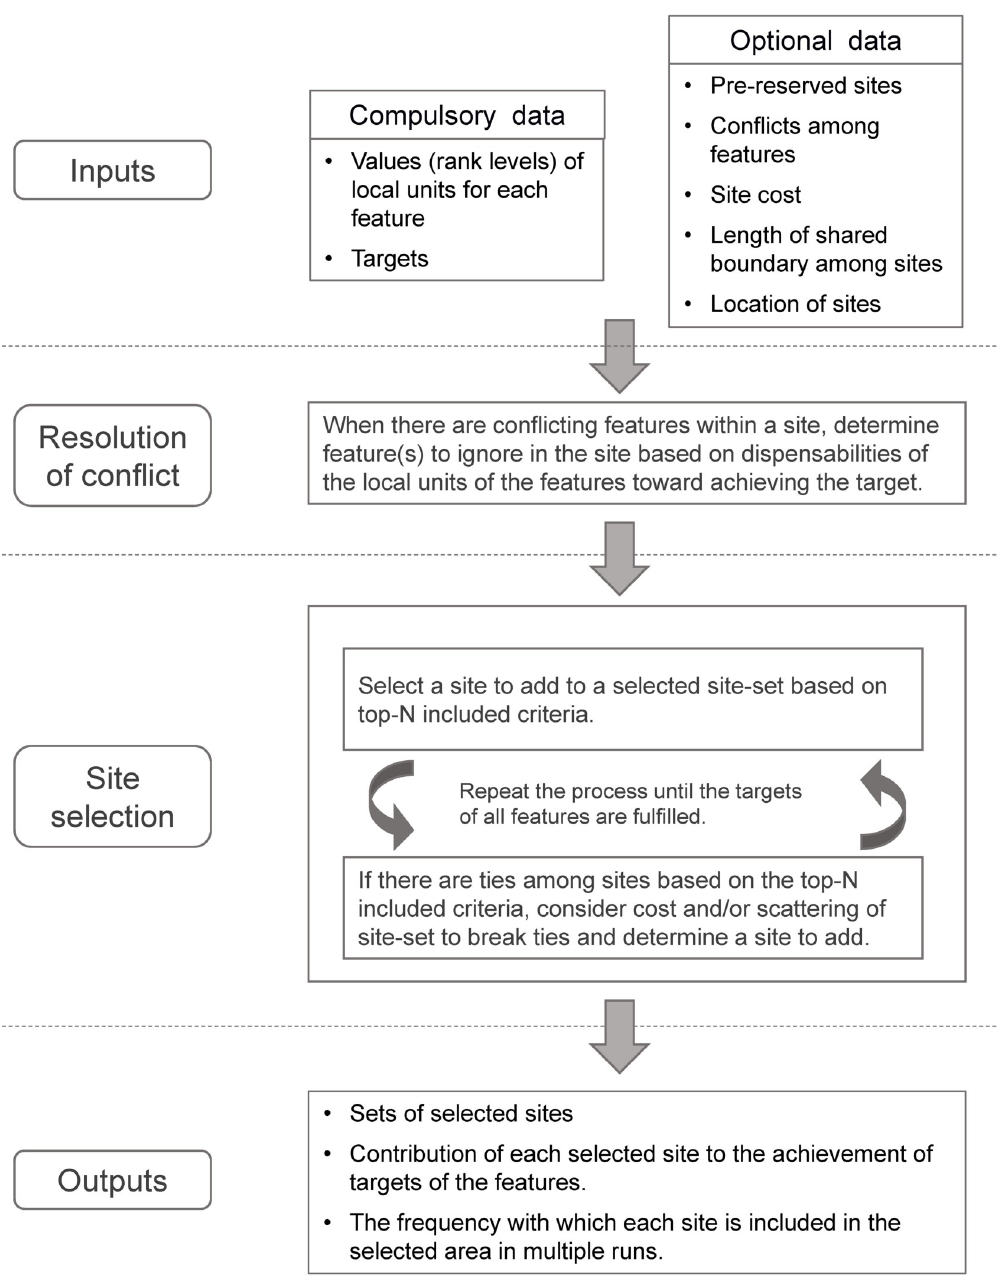
Fig 1. A graphical summary of spatial prioritization process by